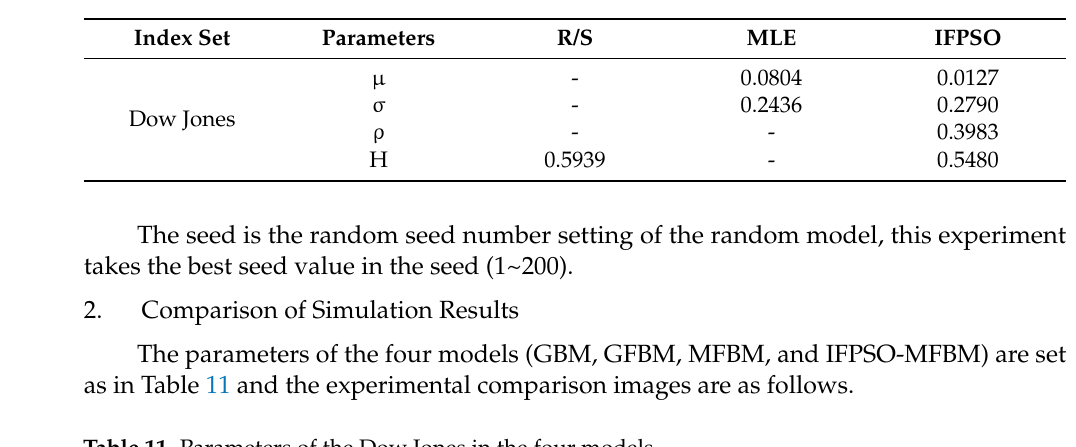
Figure 7. Comparison of Dow Jones results of algorithm optimization search. ( a ) PSO, ( b ) IFPSO. As can be seen in Table 10, the Hurst value of 0.5939 is first obtained by R/S analysis; Table 10. MFBM model parameters and optimization results for the Dow Jones index.